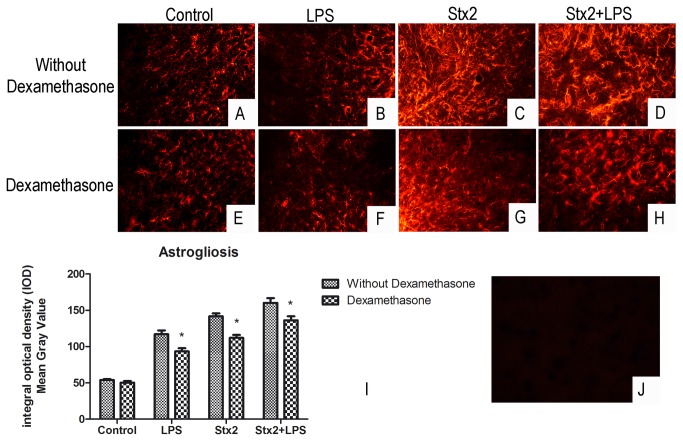
Dexamethasone reduces reactive astrocytes.Micrographs show the expression of GFAP by immunofluorescence with anti-GFAP antibody in astrocytes after four days of treatment with saline (A and E), LPS (B and F), Stx2 (C and G) and Stx2+LPS (D and H) followed by i.p. injection of saline (A through D) or Dexamethasone (E through H). Quantification of reactive astrocytes (I) under all treatments. J: negative control by not adding the primary antibody. *: significant differences between mice treated with Dexamethasone and those treated with saline (p <0.001).